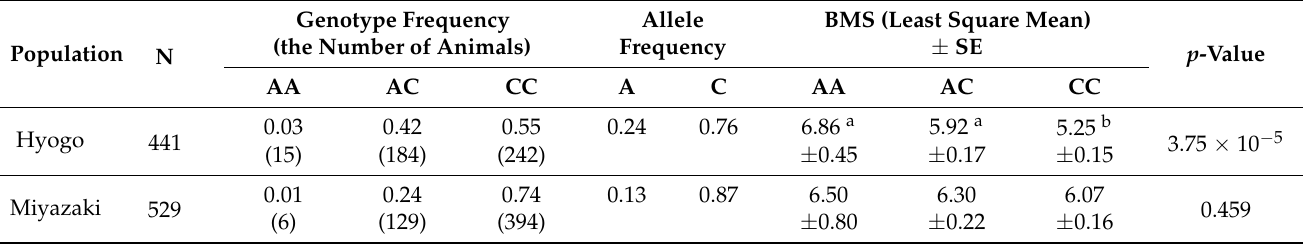
Table 1. Effect of SNP93_ ALDH7A1 on BMS in two Japanese Black populations.